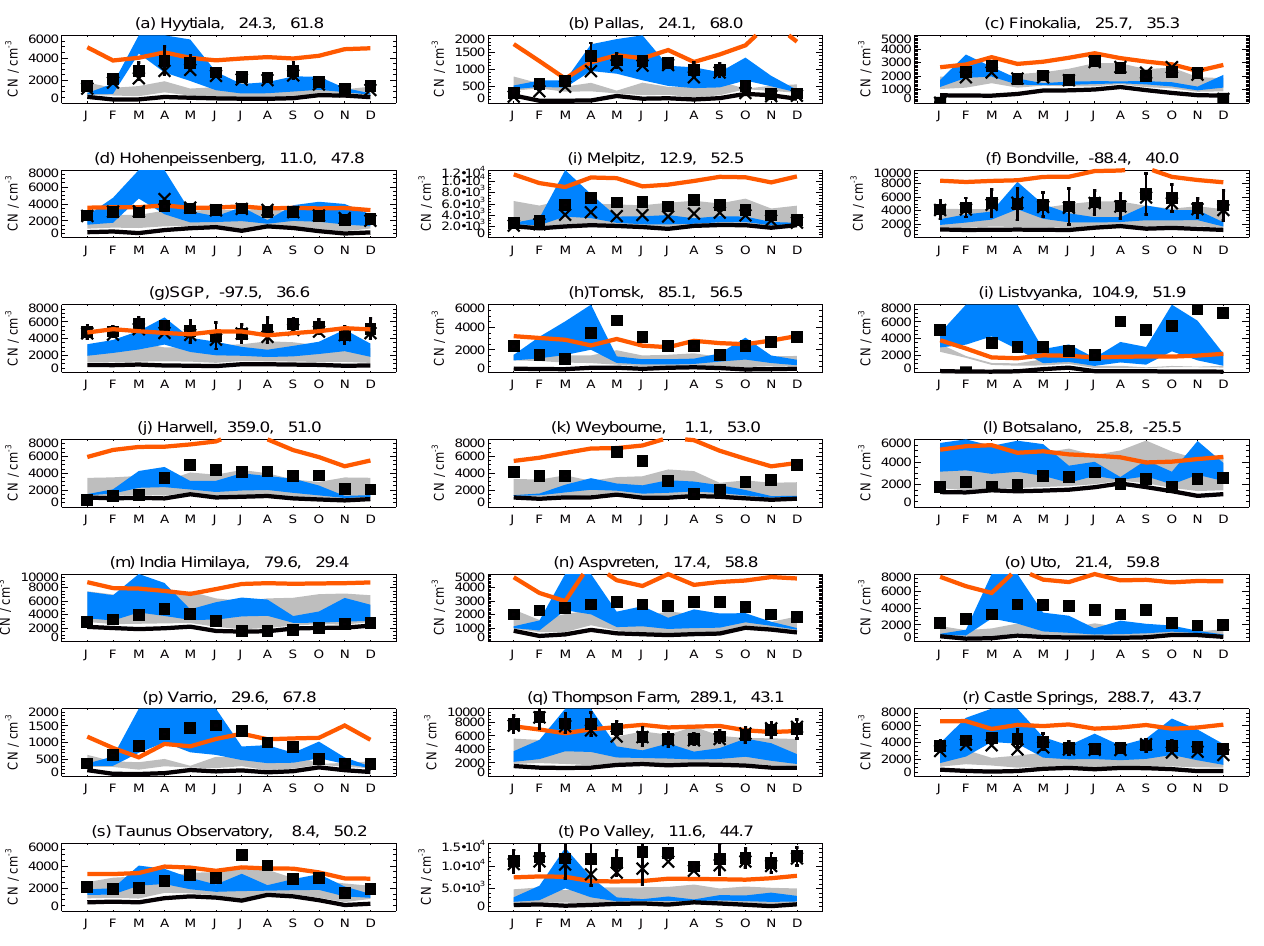
Fig. 6. As for Fig. 4 but for BL